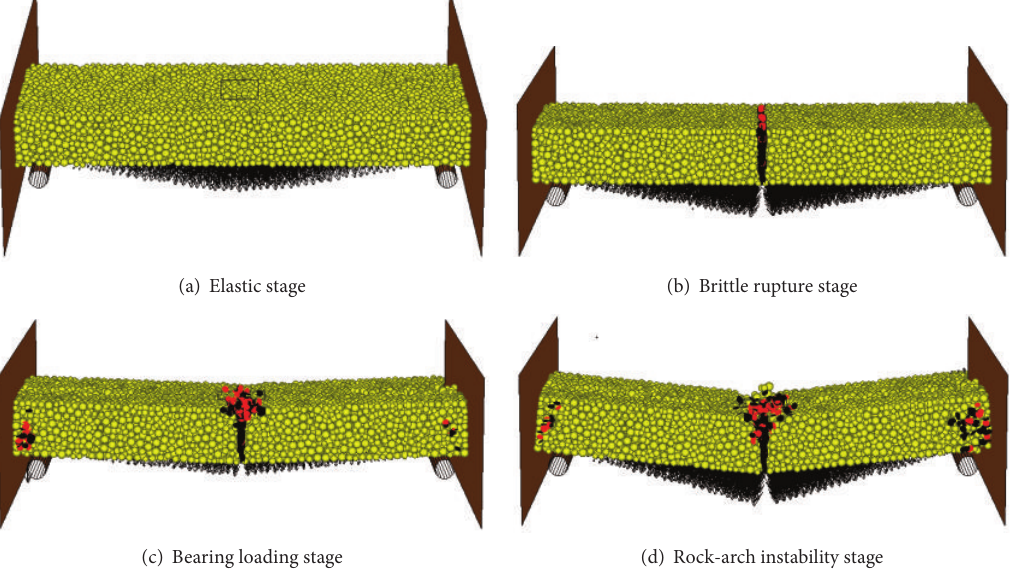
Figure 9: Rock-arch instability process under the concentrated loading.